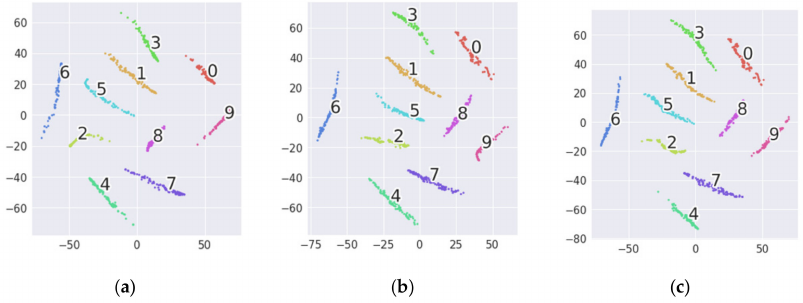
Figure 8. The two-dimensional visualization of the second full-connection layer of transfer task A → B + C. ( a ) 1D-MSDAN: source. ( b ) 1D-MSDAN: Target 1. ( c ) 1D-MSDAN: Target 2. Category 0: No, Category 1: 0.007 / IF, Category 2: 0.014 / IF, Category 3: 0.021 / IF, Category 4: 0.007 / OF, Category 5: 0.014 / OF, Category 6: 0.021 / OF, Category 7: 0.007 / RF, Category 8: 0.014 / RF, Category 9: 0.021 / RF.